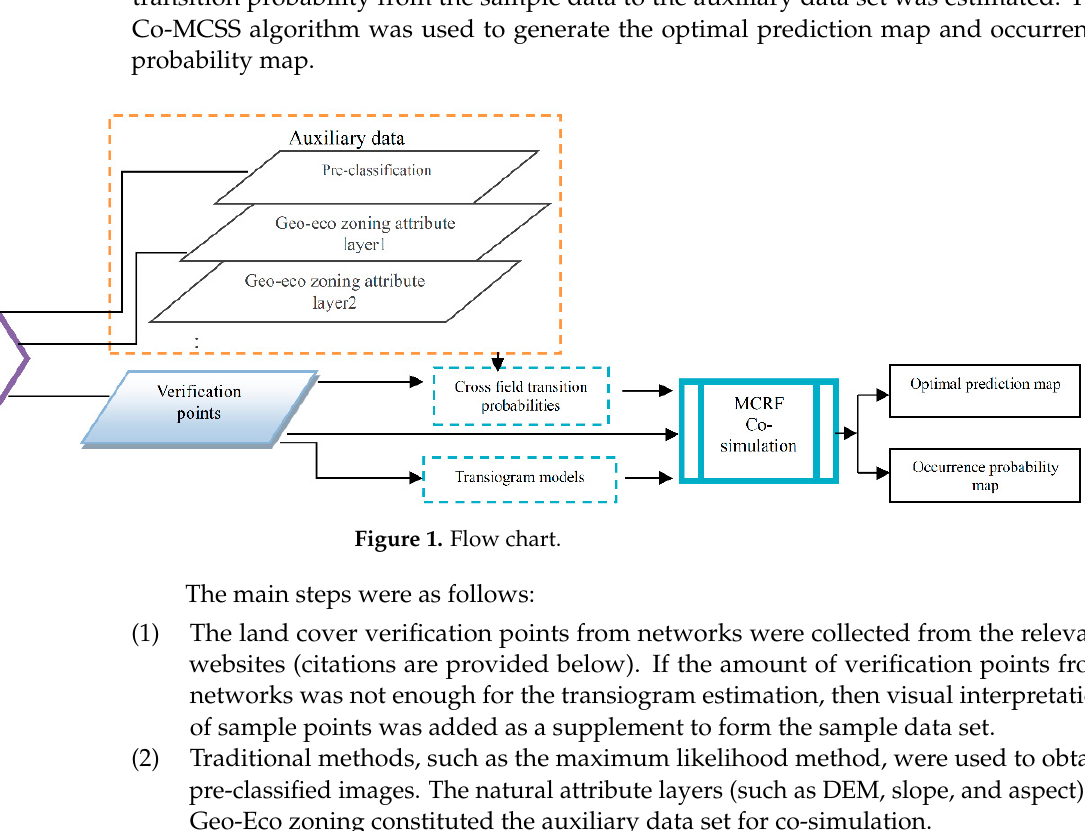
Figure 1. Flow chart.